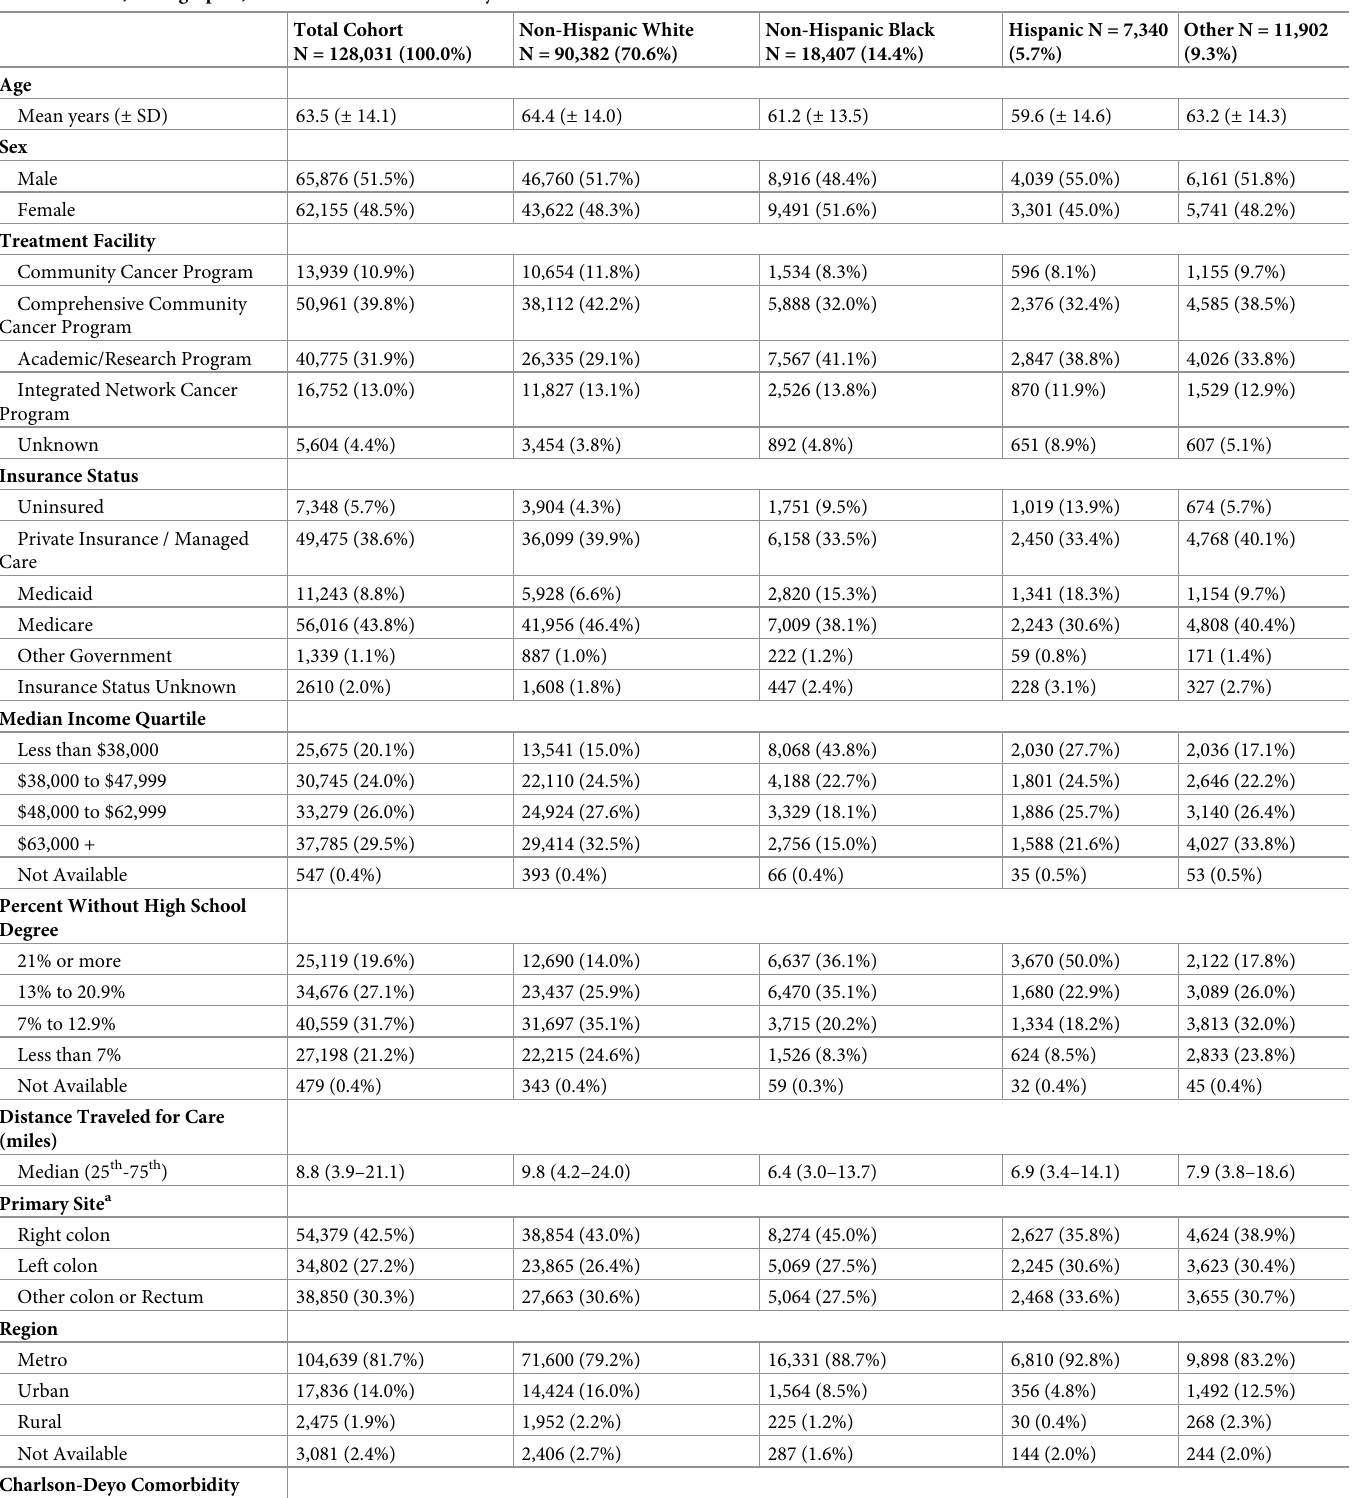
Table 1. Social, demographic, and clinical characteristics by race.